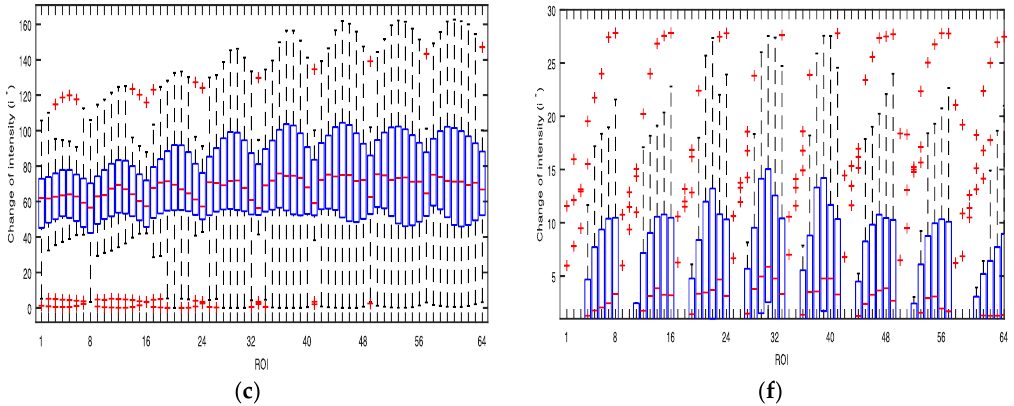
Figure 8. Box plot of the average values of 𝑖 ∗ of the three color bands obtained from the 64 ROIs of the Galaxy S6 and the Galaxy Note 3 from 30 subjects while shaking the cushion horizontally: ( a ) Red (Galaxy S6); ( b ) Green (Galaxy S6); ( c ) Blue (Galaxy S6); ( d ) Red (Galaxy Note 3); ( e ) Green (Galaxy Note 3); ( f ) Blue (Galaxy Note 3).